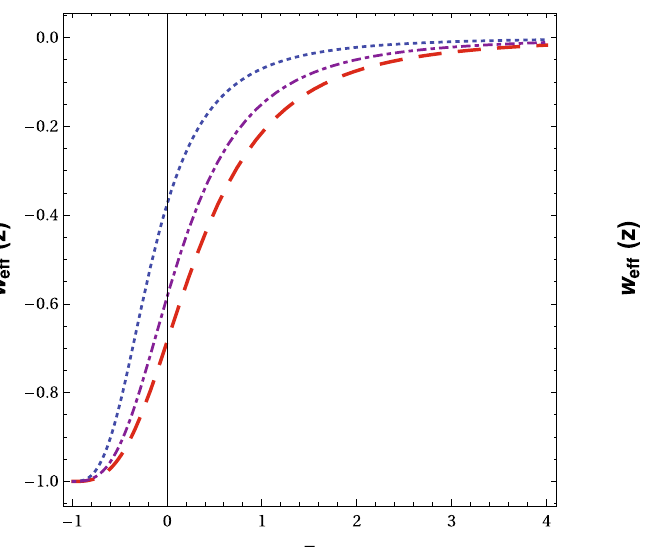
and values of z . In the far future, w ef f ( z ) approaches the equation of state l 1 of constant (cid:3) . On the other hand, when z → ∞ , the effective equation